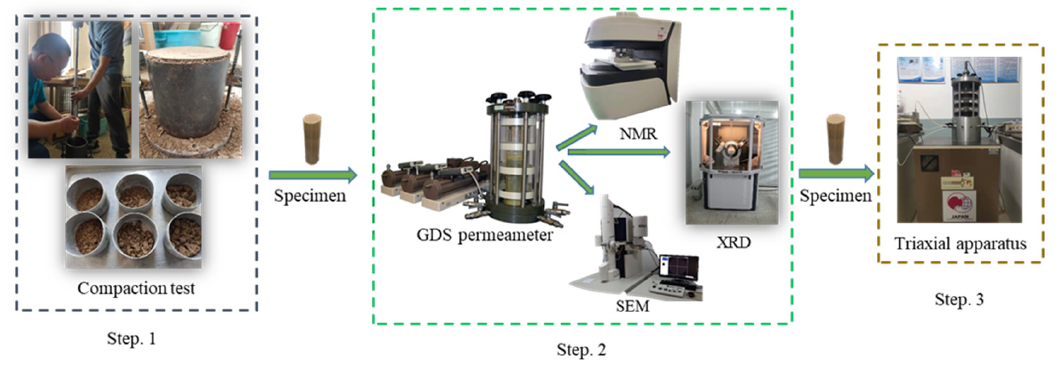
Figure 1. Experimental flow chart.